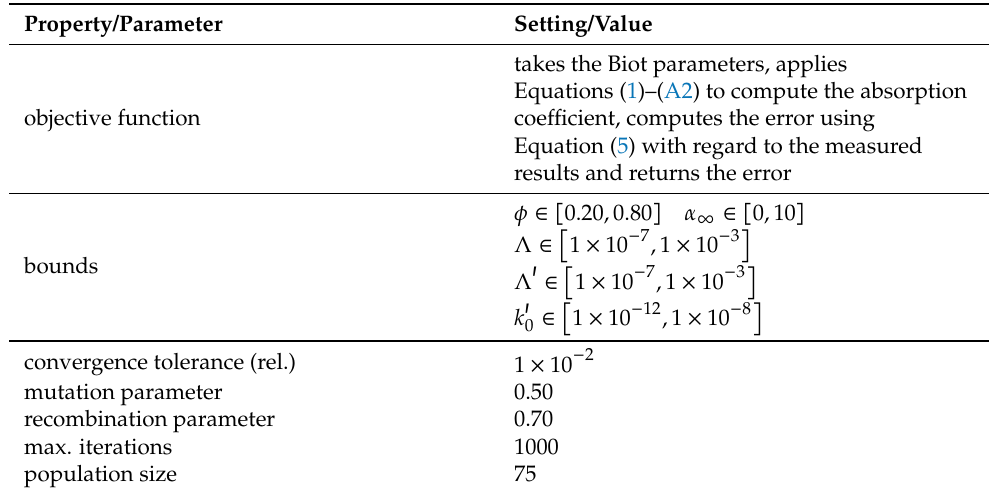
Table A2. Settings of the evolutional algorithm used for the inverse parameter identification procedure. The implementation of the algorithm is used from the python library scipy [ ? ] an follows [ ? ]